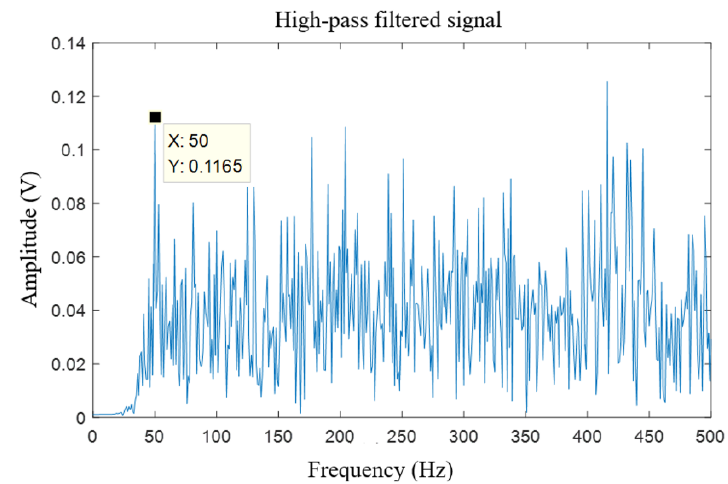
Figure 6. The frequency domain waveform of the high-pass filtered signal.